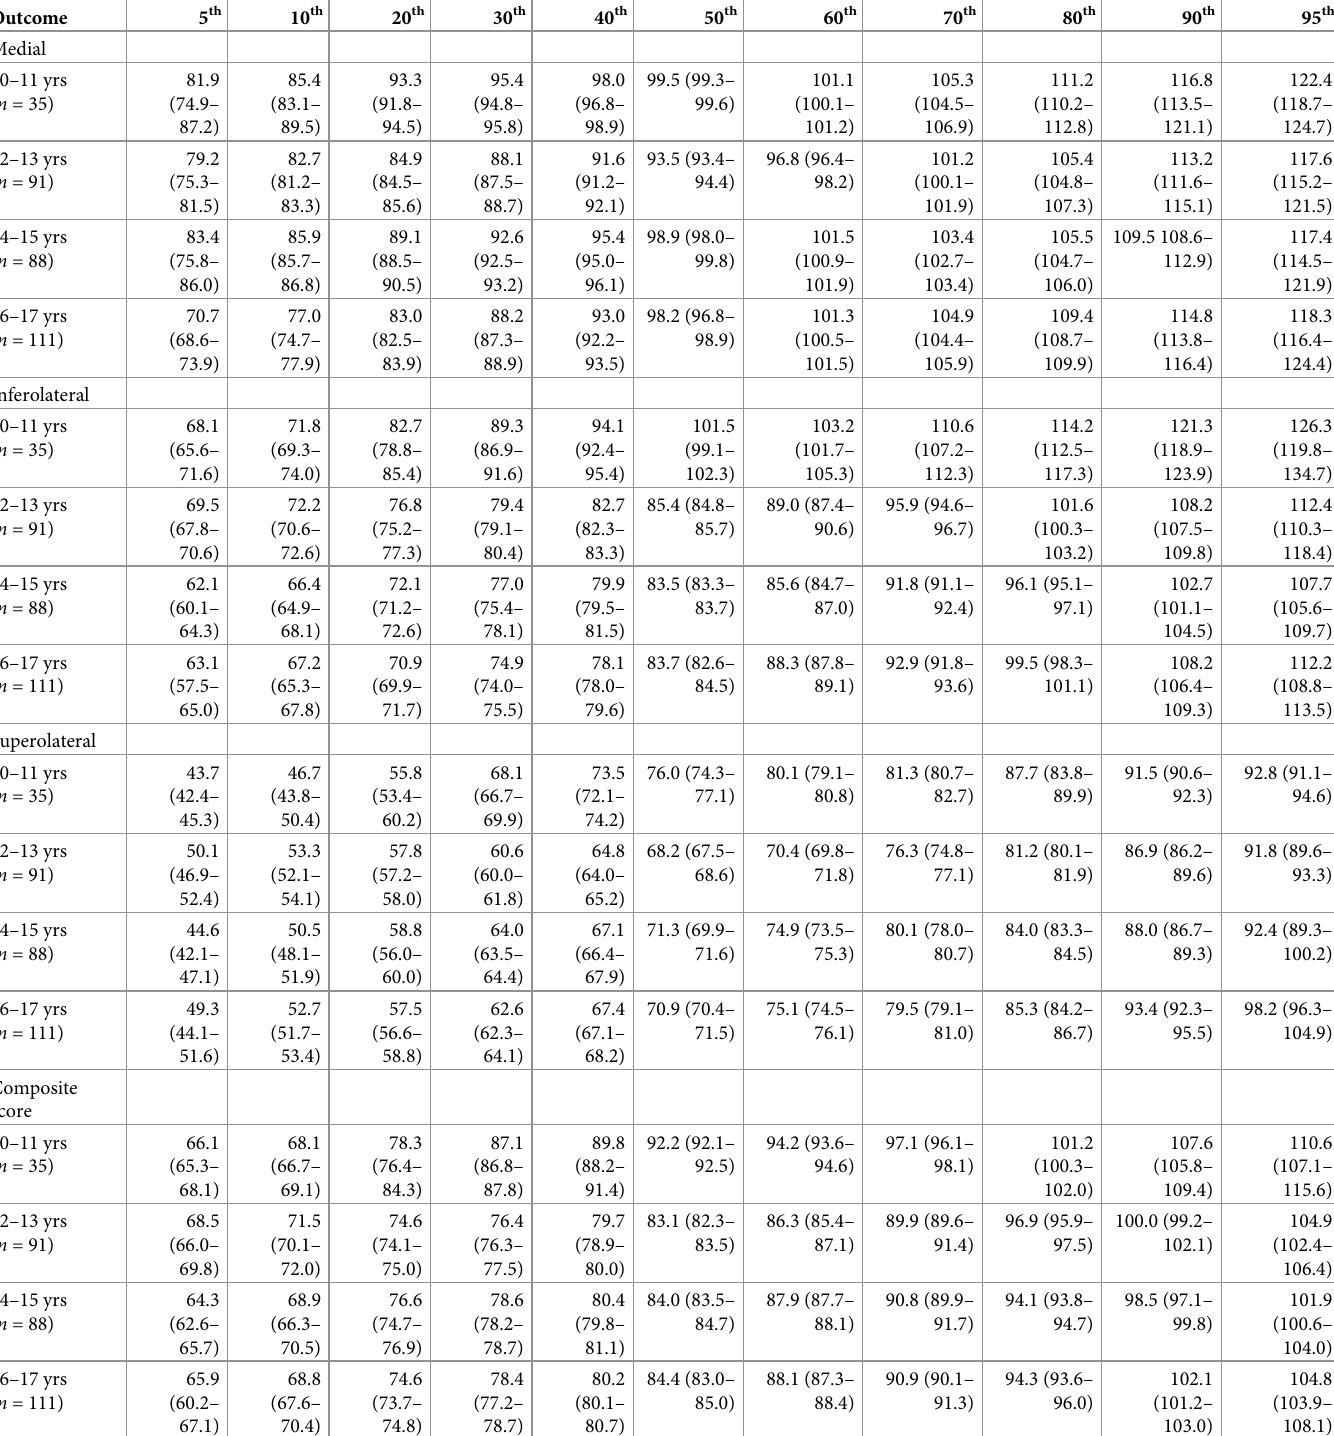
Table 5. Smoothed age-specific percentile values with 95% confidence interval for the normalized (% arm length) maximal right arm reach distances and the com- posite score in females ( n = 325) aged 10 to 17